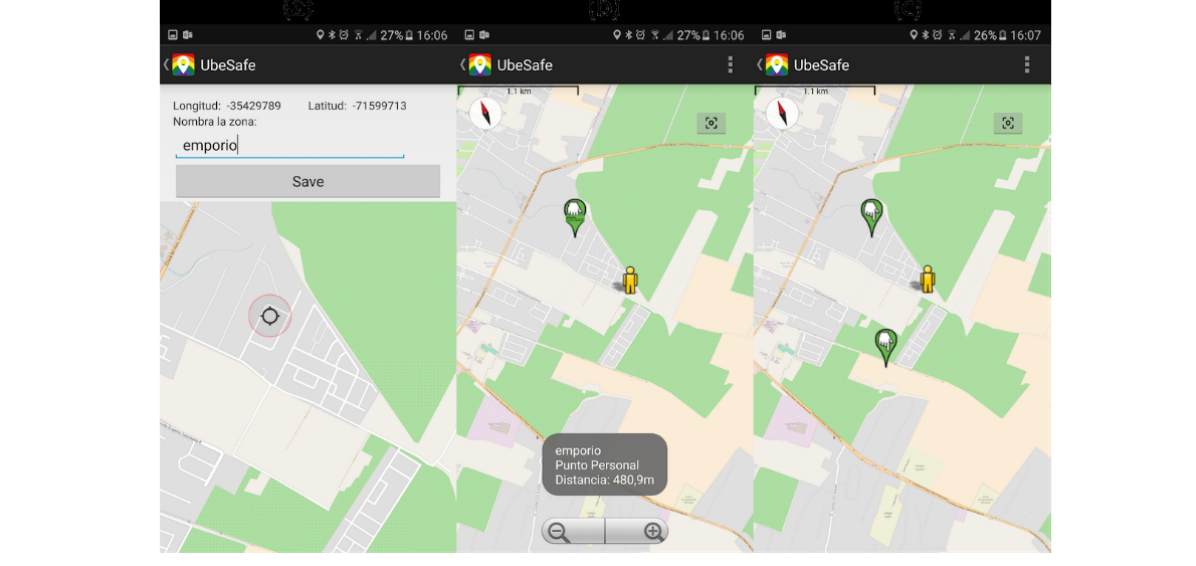
Managing Health